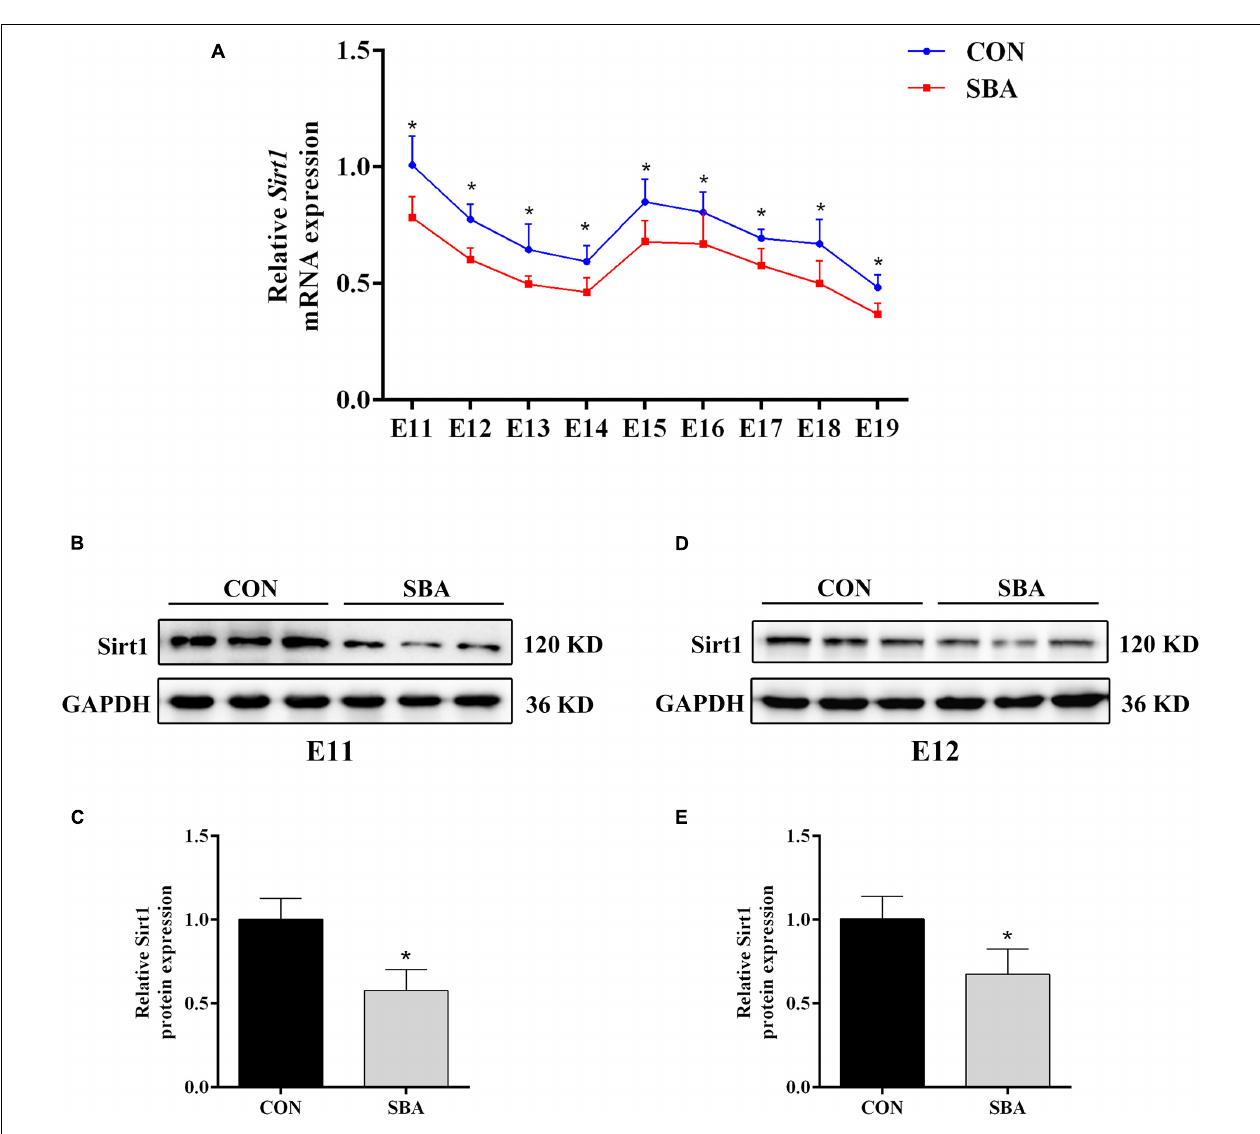
FIGURE 2 | Sirt1 expression in ATRA-induced SBA. (A) Relative Sirt1 mRNA expression in rat embryonic spinal cord tissues of the CON and SBA groups from E11 to E19 as assessed by RT-qPCR ( n = 5). Results are expressed as the mean ± SD. * p < 0.05 vs. control group. (B) Western blot of Sirt1 in rat embryonic spinal cord tissues on E11 in the CON and SBA groups. (C) Quantitation of Sirt1 protein on E11 ( n = 6). (D) Western blot of Sirt1 in rat embryonic spinal cord tissues on E12 in the CON and SBA groups. (E) Quantitation of Sirt1 protein on E12 ( n = 6). Results are expressed as the mean ± SD. * p < 0.05 vs. control group.